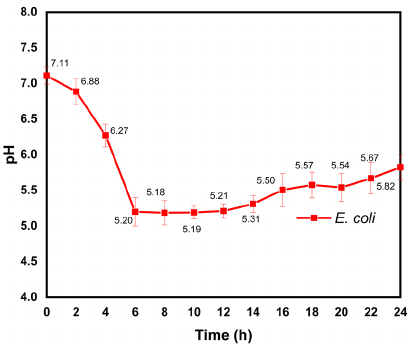
Figure 7. The pH changes of E. coli growing in